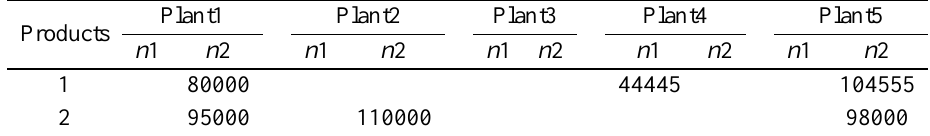
Table 10. Production quantity in planning period